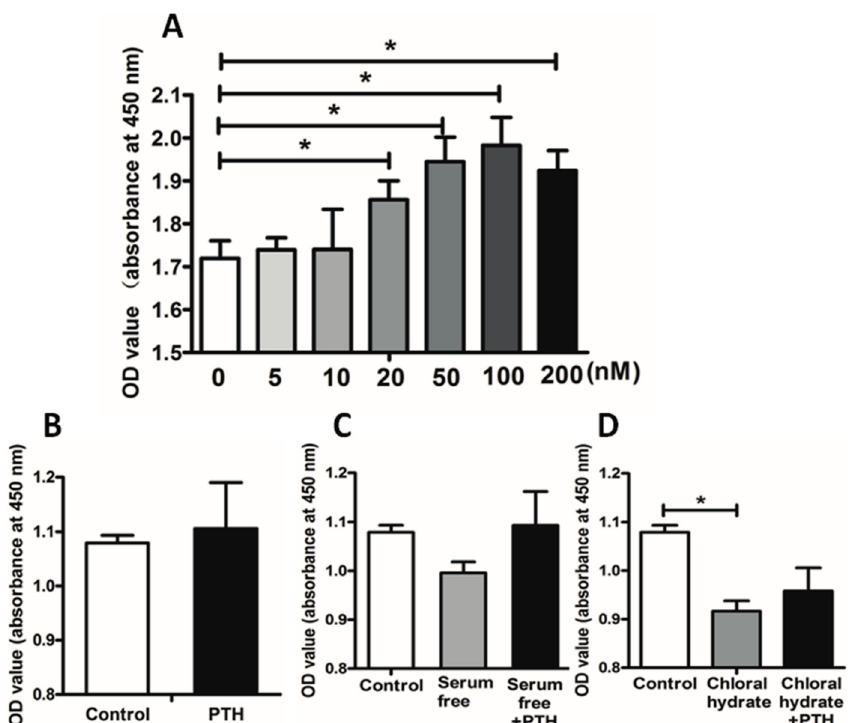
Figure 2. PTH promoted SW1353 cell proliferation by acting on primary cilia. Image A shows the effect of different concentrations of PTH on SW1353 proliferation; Image B shows the effect of PTH on tumor cell; Image C shows the effects that serum free medium and PTH on tumor cell proliferation; Image D shows the influences that chloral hydrate and PTH stimulation on proliferation ability. ( * p <